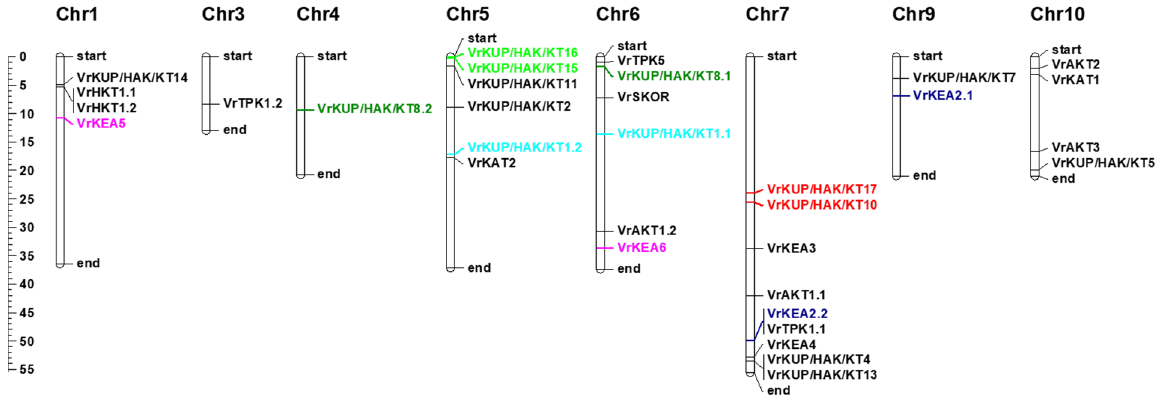
Figure 3. Chromosomal mapping of potassium transport-related genes. Tandem duplications are indicated by multiple colors and segmental duplications are shown in a red color. The same color indicates that the gene pair is duplicated. The scale at the left side of the chromosomal bar denotes the position on the chromosome (megabase pairs; Mb).